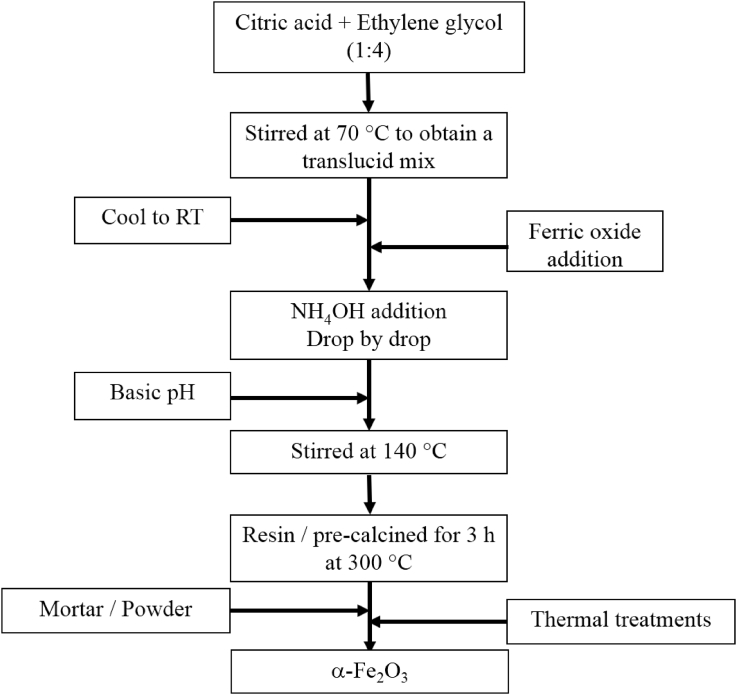
Flowchart for the synthesis of α-Fe2O3 nanoparticles by Pechini method.